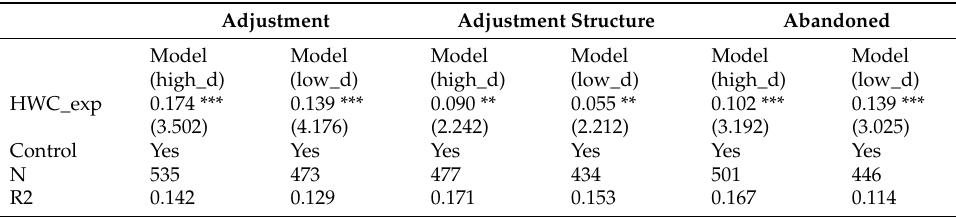
Table 6. Differences in the dependence rate of livelihood on cultivated